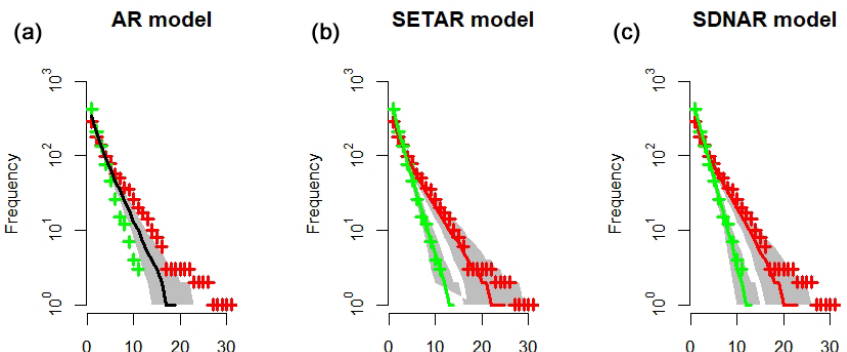
Figure 6. Durations of the positive and negative phase of the NAO index as compared to durations derived from the AR (a) , SETAR (b) and SDNAR (c) models. The plots show the absolute frequency of positive (green crosses) and negative (red crosses) phase events of the winter NAO index persisting more than a particular number of days. These frequencies are compared to those computed by the models for which the median (green and red lines, respectively) and 5%–95% range (grey regions) of 1000 realizations are displayed. For the AR models, the green and red lines overlap and are replaced by a black